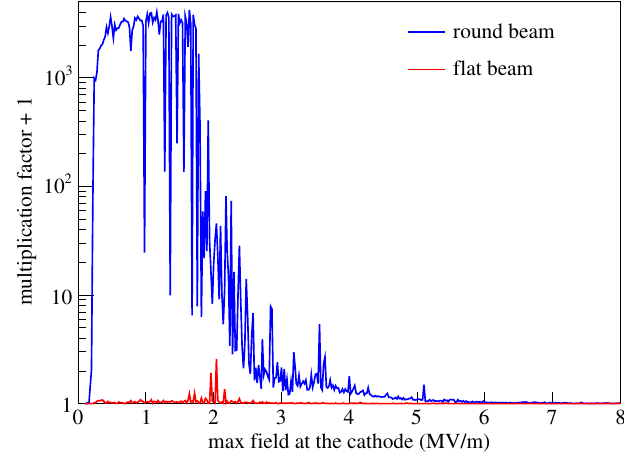
FIG. 21. (Color) Multiplication factor after 140 rf cycles for the FNPL gun with two different solenoid configurations. In this simulation, 1000 seed particles were used and the secondary generation was limited to 6 (cid:3) 10 6 particles. The multiplication factors between 0.5 and 1 : 6 MV = m are therefore underestimated for the round beam configuration. As before, 1 is added to the multiplication factor for visualization on a logarithmic